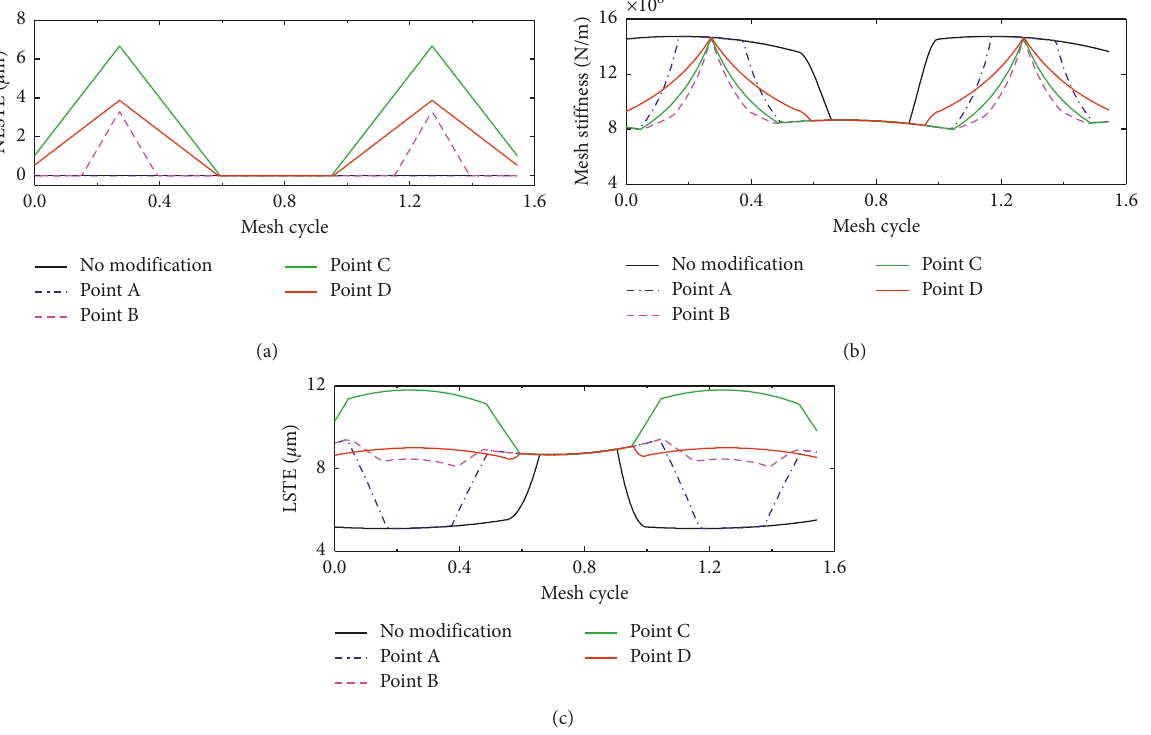
Figure 18: Time-varying mesh stiffness and transmission errors of a ring gear-mesh gear pair at different points: (a) no-load static transmission error, (b) time-varying mesh stiffness, and (c) loaded static transmission error.